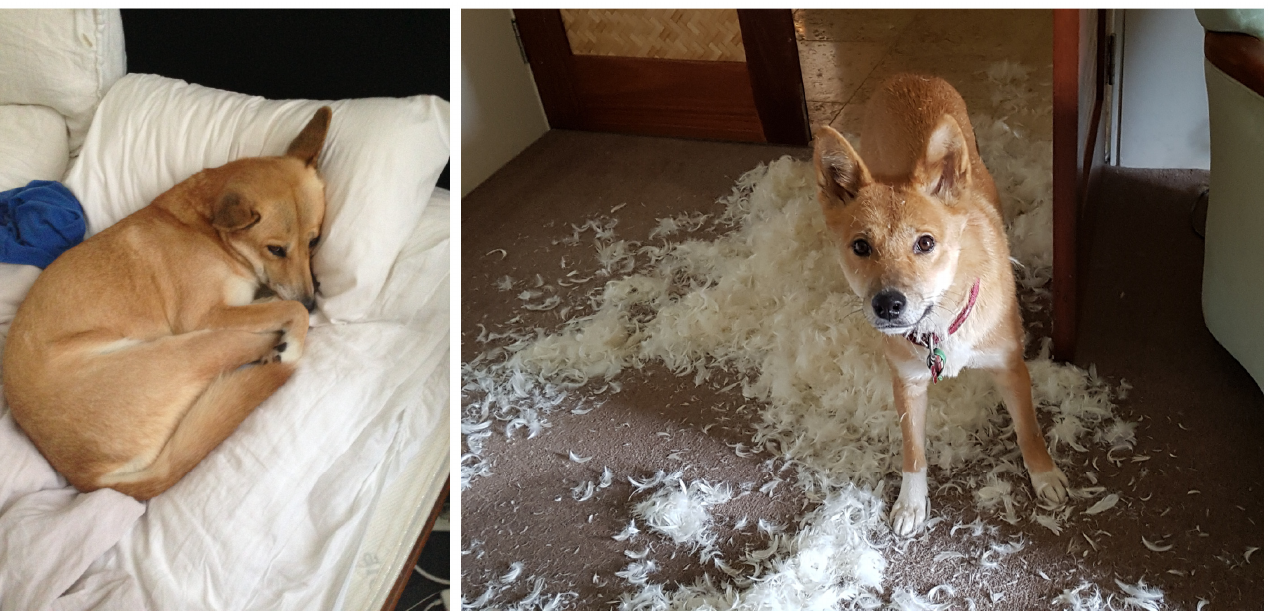
Figure 6. Dingoes kept as household pets in present-day suburban Australia. The dingo at right has just destroyed the owner’s pillow (image credit: Mel Browning). The photograph of the dingo on the couch is courtesy of Desiree Hemberger.